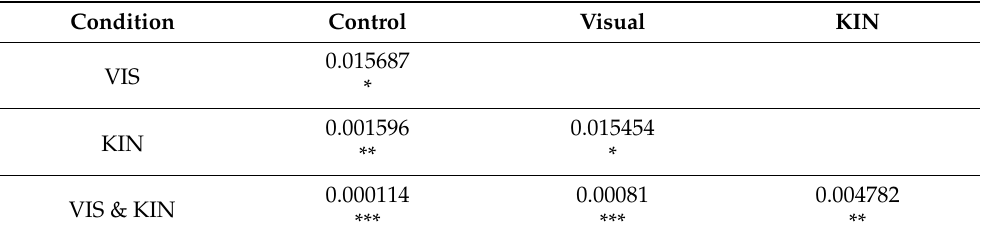
stimulation conditions and the control condition. We found significant differences for all